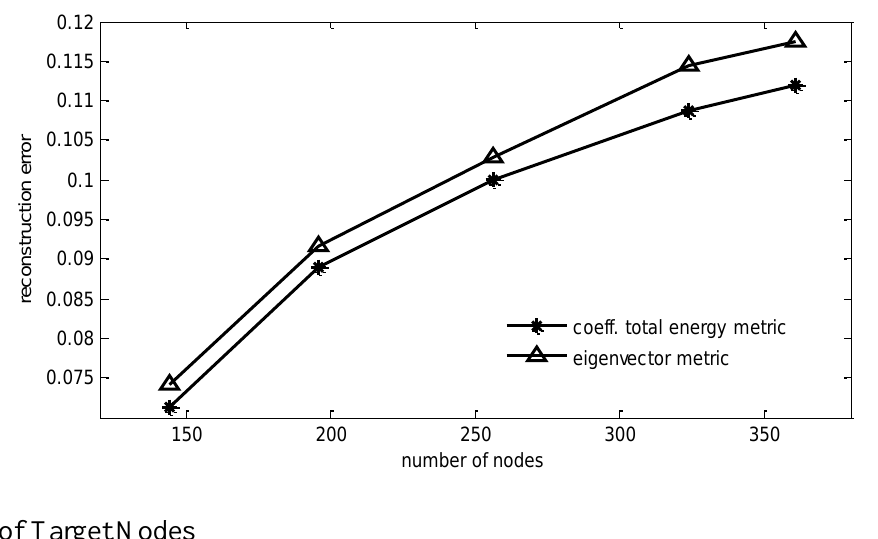
Figure 13. Reconstruction error for different node selection